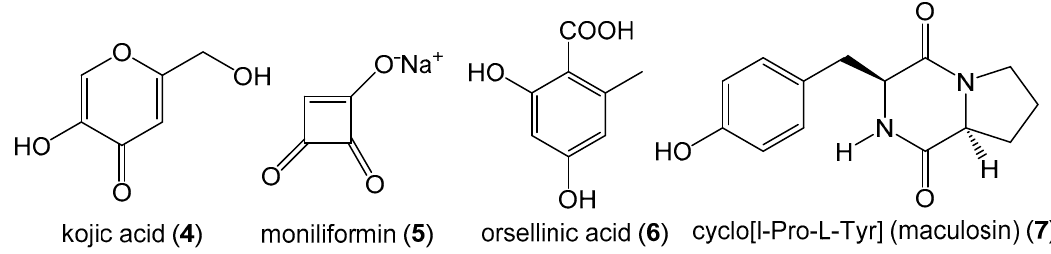
Figure 3. Structures of mycotoxins and secondary metabolites produced in culture media by M. Figure3. Structuresofmycotoxinsandsecondarymetabolitesproducedinculturemediaby M.phaseolina